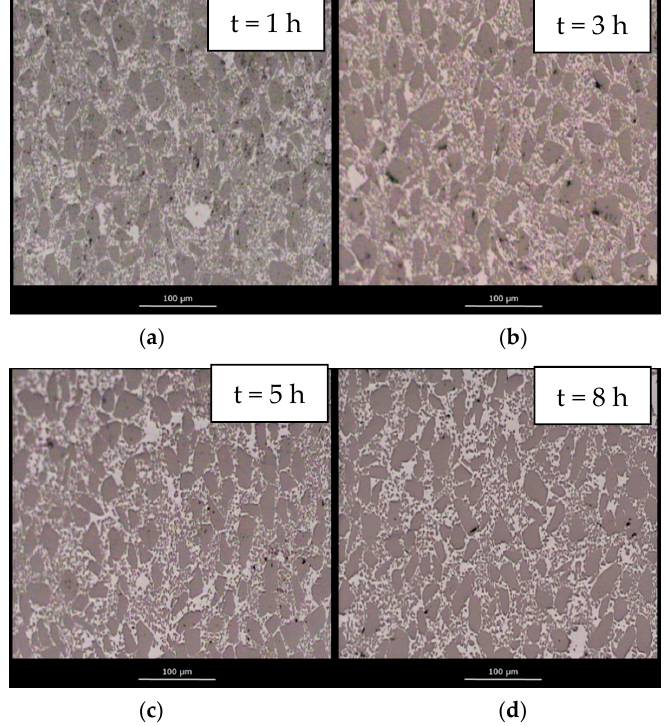
Figure 9. Evolution of the microstructure of SiC p /Si composite materials infiltrated at 1450 °C under a vacuum atmosphere with a 1 h ( a ), 3 h ( b ),5 h ( c ) and 8 h ( d ) dwell time.